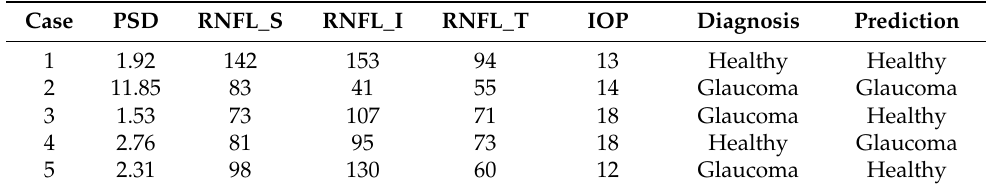
Table 6. Cases of prediction by the proposed model.